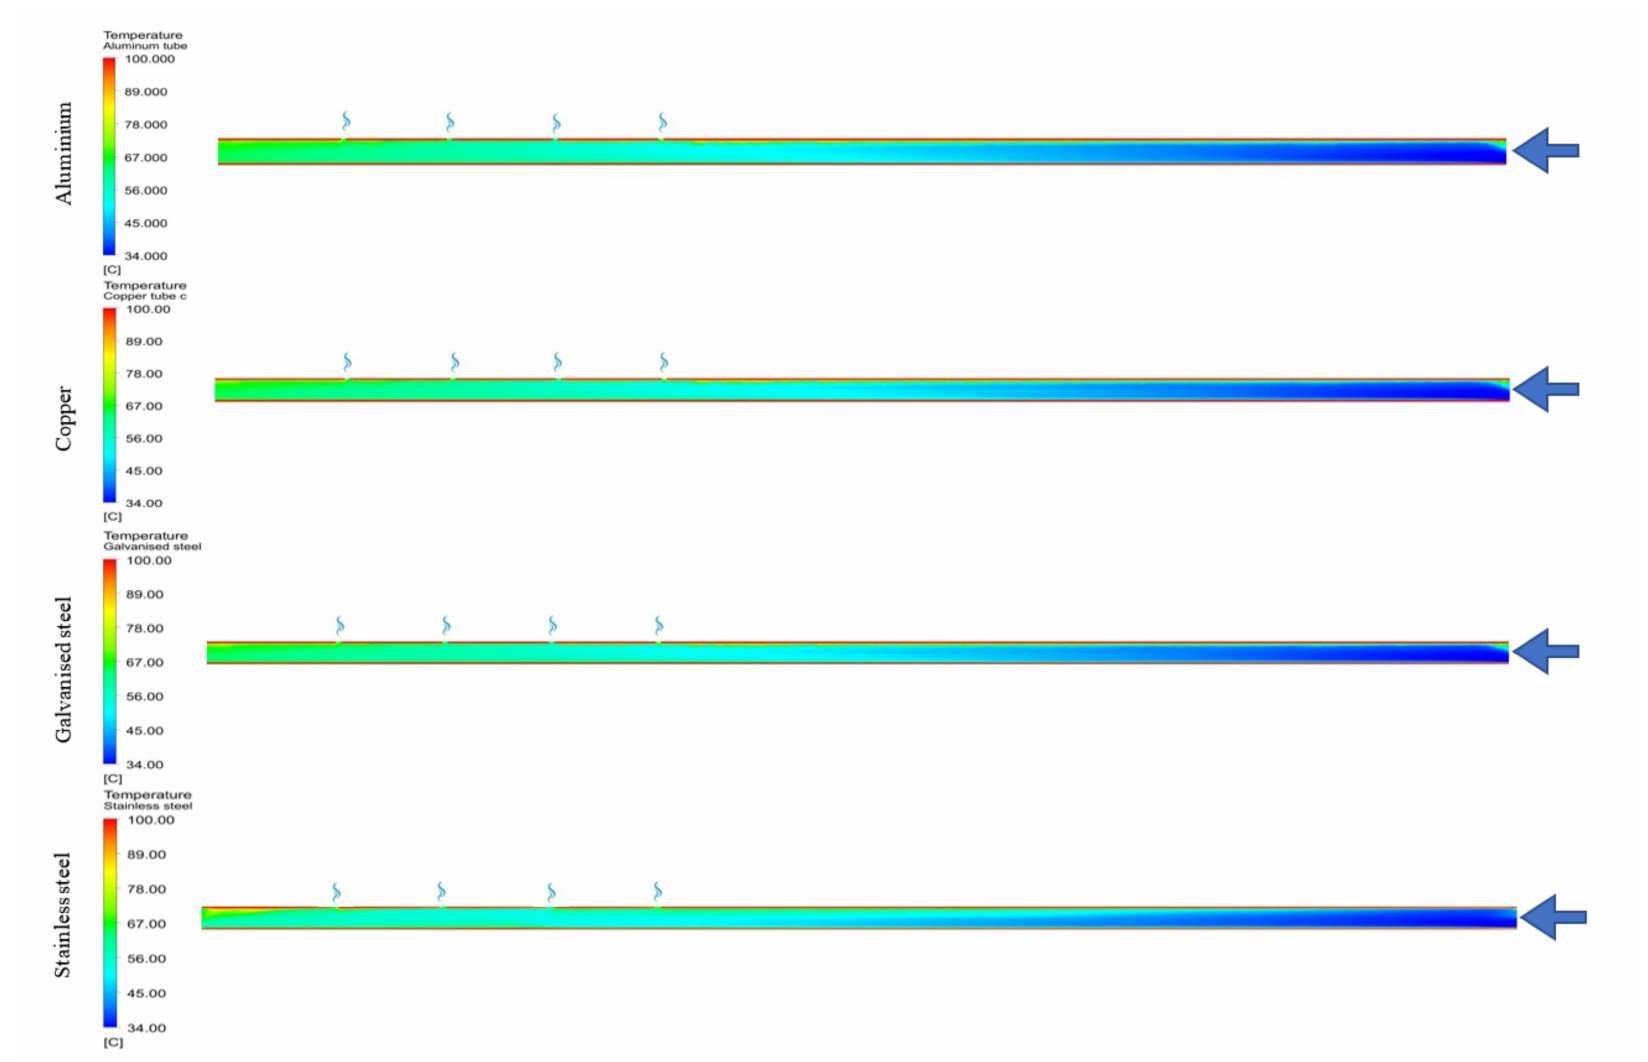
Figure 7. Temperature contours corresponding to surface temperature (100 ◦ C) for di ff erent receiver tube